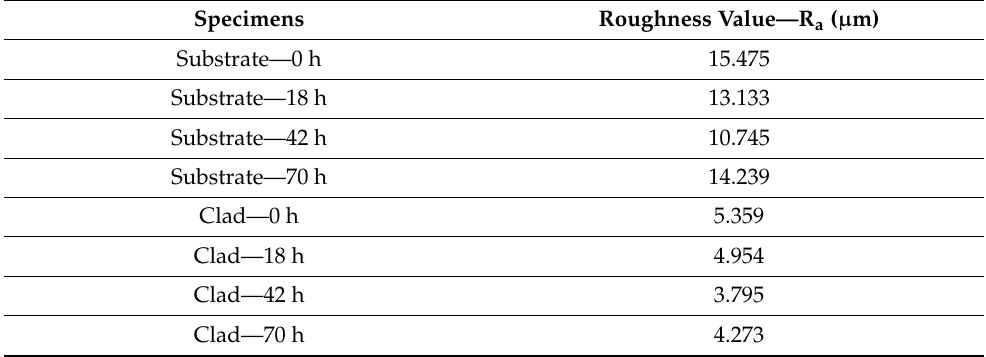
Table 6. Roughness values of substrate and cladded samples after corrosion